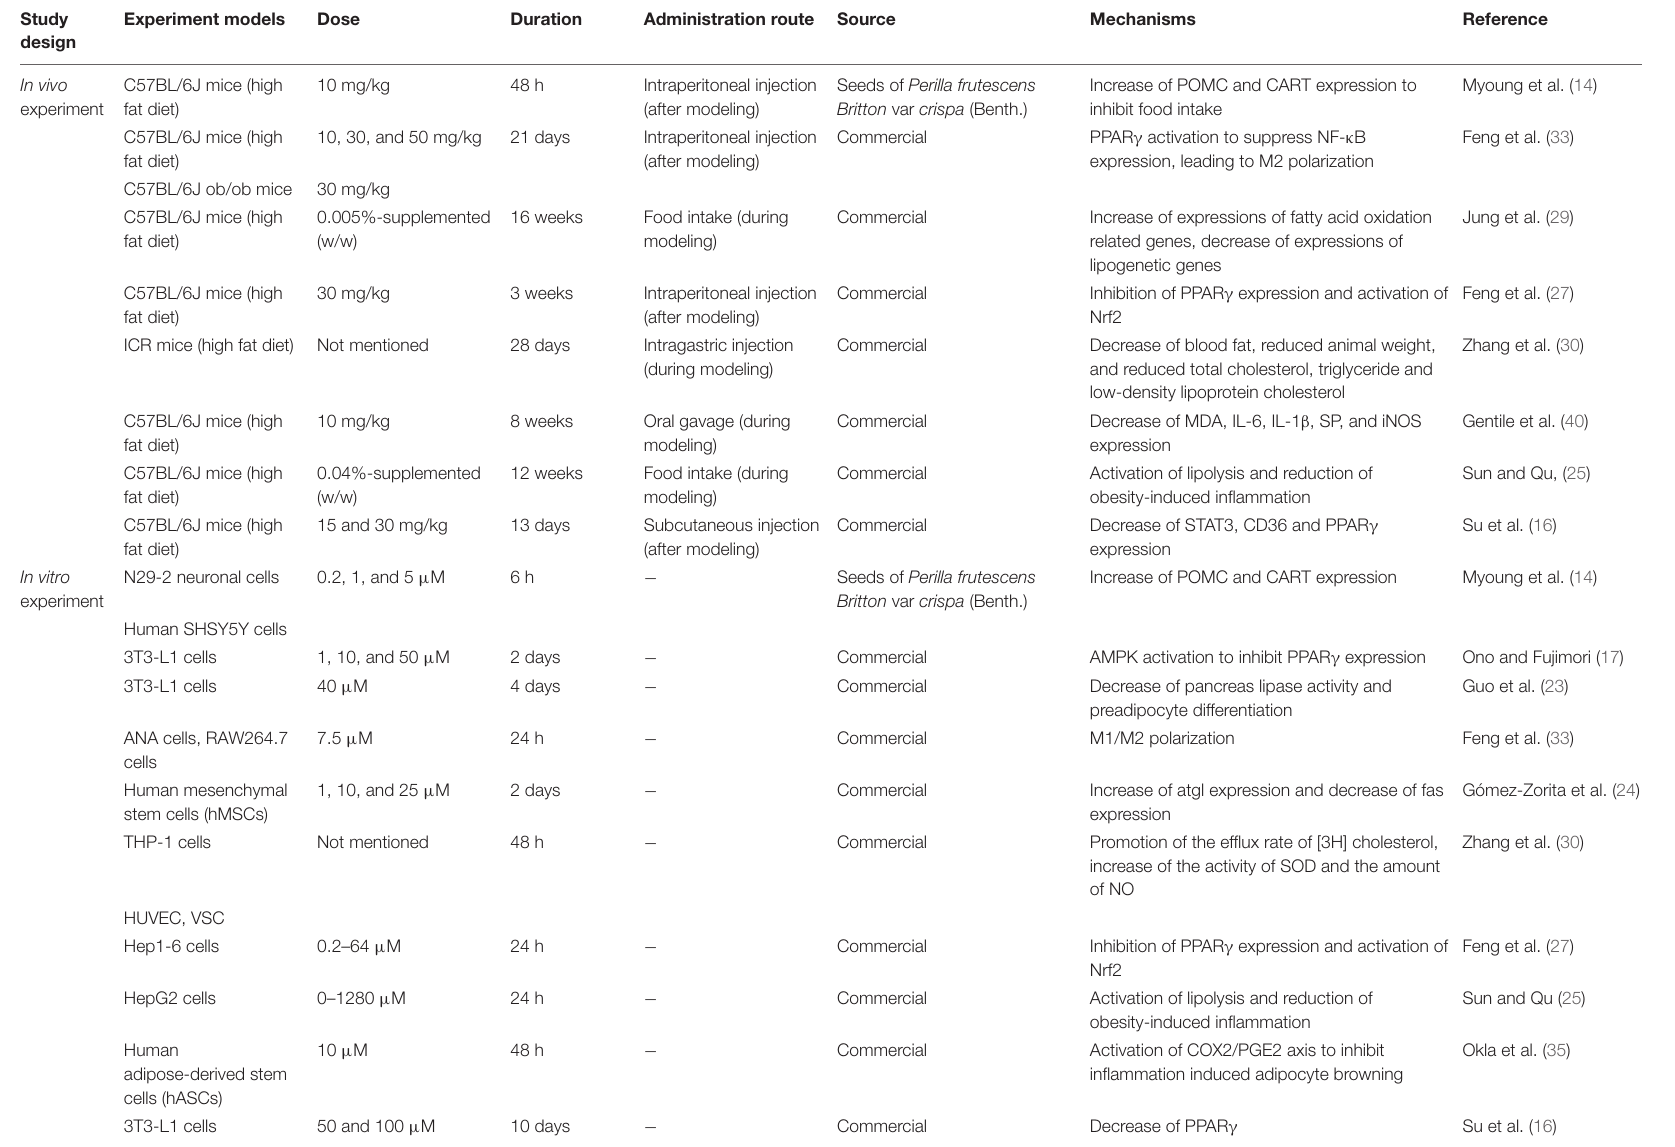
TABLE 1 | Experiment designs and effects of apigenin on obesity and lipid metabolism ( in vivo and in vitro ). Study